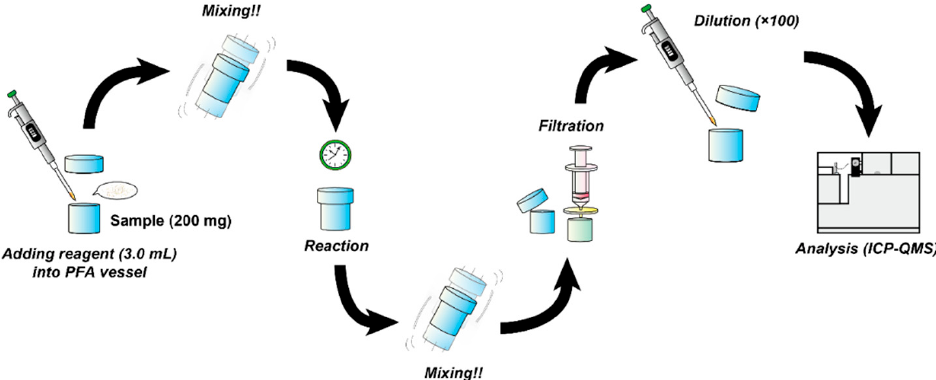
Figure 2. Schematic diagram of the procedure for the leaching